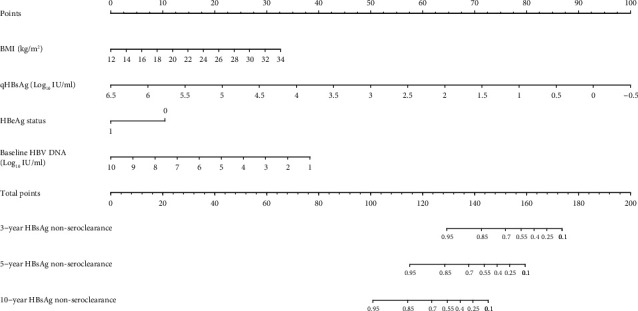
Nomogram predicting the probability of HBsAg non-seroclearance at 3, 5, and 10 years, using BMI, quantitative HBsAg (qHBsAg), HBeAg status, and baseline HBV DNA. To use the nomogram, an individual patient's value is located on each variable axis, and a line is drawn upward to determine the number of points received for each variable value. The sum of these numbers is located on the total points axis, and a line is drawn downward to the non-seroclearance axes to determine the likelihood of 3-year, 5-year, and 10-year non-seroclearance. BMI: body mass index; qHBsAg: quantitative hepatitis B virus surface antigen; HBeAg: hepatitis B virus e-antigen (0 and 1 represent negative and positive status, respectively); baseline HBV DNA: baseline hepatitis B viral deoxyribonucleic acid load.